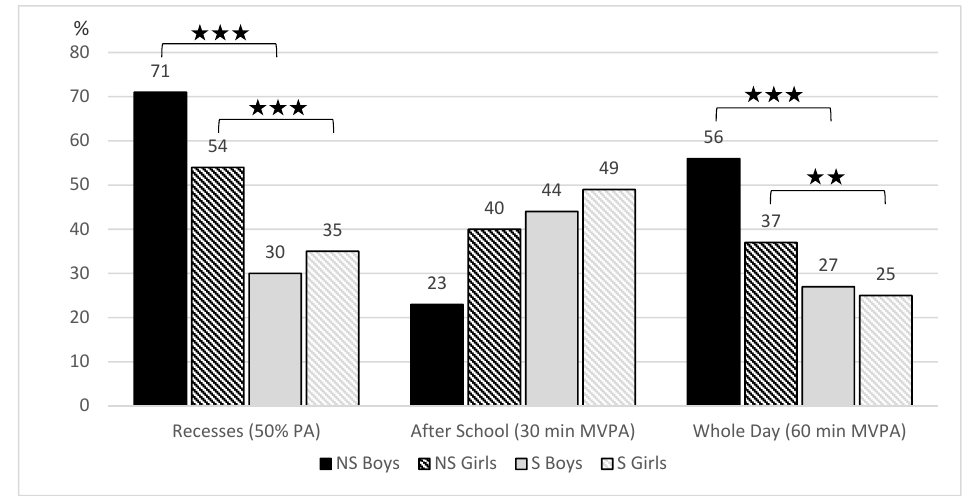
Figure 2. Meeting the guidelines for physical activity (PA) in di ff erent day segments (50% of PA